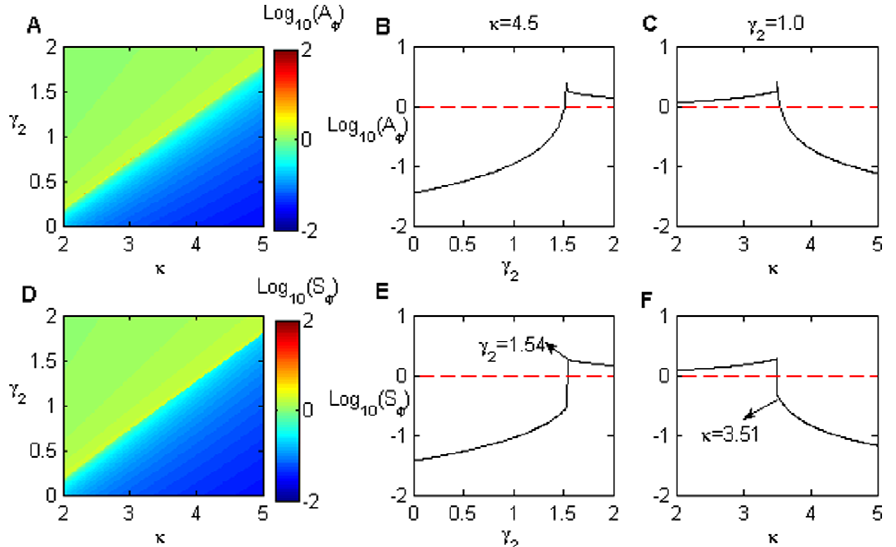
Figure 5. The effects of the positive feedback ( k ) and miRNA inhibition ( c 2 ) with initial steady on-state. (A) The noise amplification and (D) the sensitivity of the protein module as a function of k and c 2 when the initial stable steady state is on-state in a bistable region. A w and S w for k ~ 4 : 5 (B, E) and c 2 ~ 1 : 0 (C, F), respectively. Note that A w and S w reach their maximum values at c 2 ~ 1 : 54 (B, E) and k ~ 3 : 51 (C, F), respectively. The parameters values are a ~ 0 : 15 , c 1 ~ 1 : 0 , e ~ 0 : 05 , and t 0 ~ 0 : 5 .